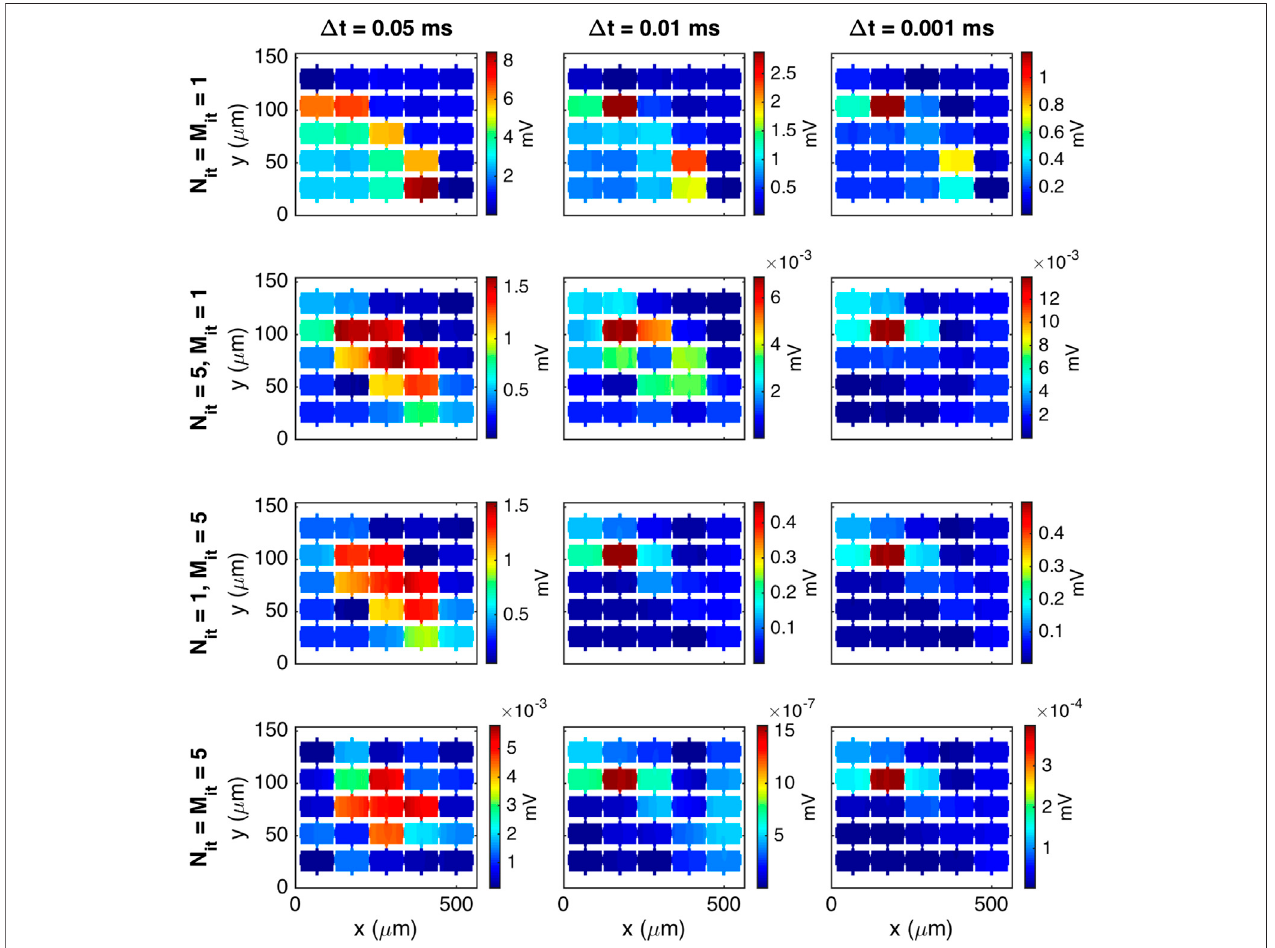
FIGURE10| Absolutevaluesofthedifferencein u i computed usingthecoupledandsplittingapproachesfordifferentcombinationsofthetimestep, Δ t ,numberof outer iterations, N it , and number ofinner iterations, M it . The solutions are compared inthe center ofthe domain in the z -directionat t (cid:2) 2 . 5 ms, and theparametersused in the simulations are speci fi ed in Tables 1 and 3